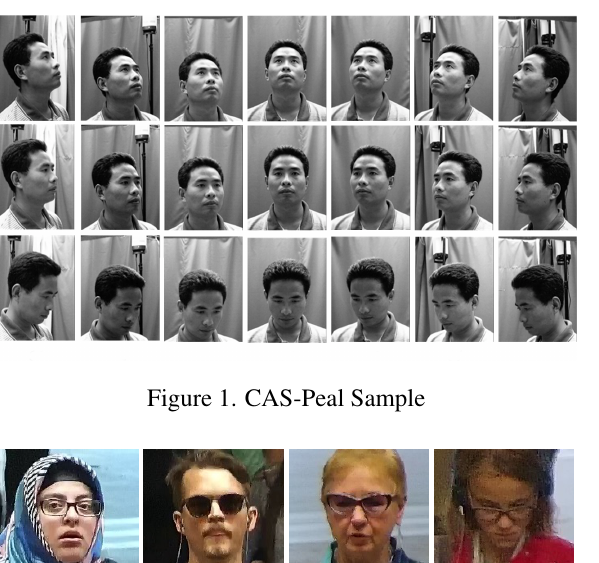
Figure 2. Prepared dataset